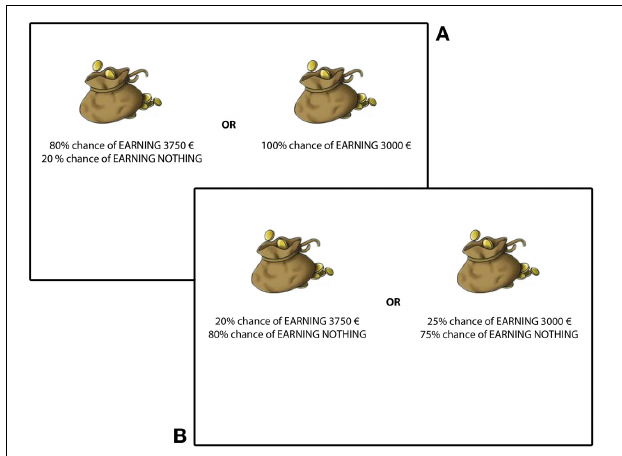
FIGURE 1 | Two sample pairs of choices between gains. On top (A) , patients have to choose between a risky investment (left) and a secure investment (right) in a high probabilities lottery. Below (B) , patients have to choose between risky investment (left) and a secure investment (right) in a low probabilities